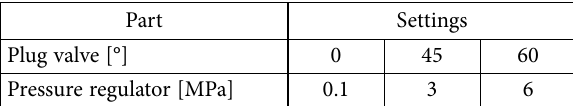
Table 3. System parts and their setting for different